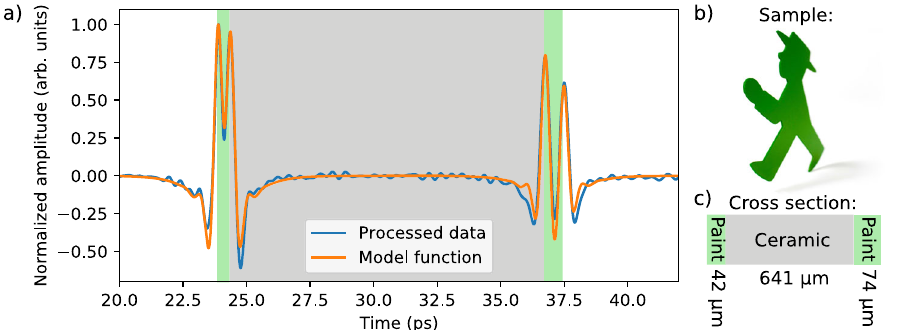
Fig. 8 Re fl ection measurement data and model of a three-layer sample. a Processed time-of- fl ight signal (blue) and model function (orange) of a three- layer sample. The tree layers are indicated by the areas shaded in green and gray. b The samples outer shape resembles a traditional Berlin traf fi c light fi gure. c The three-layer samples inner structure: green paint on the front side, a ceramic substrate, and another green paint layer on the backside. Note that the model function reproduces the individual peaks of the data trace accurately. A sketch of the sample and its cross-section showing the layer stack are depicted on the